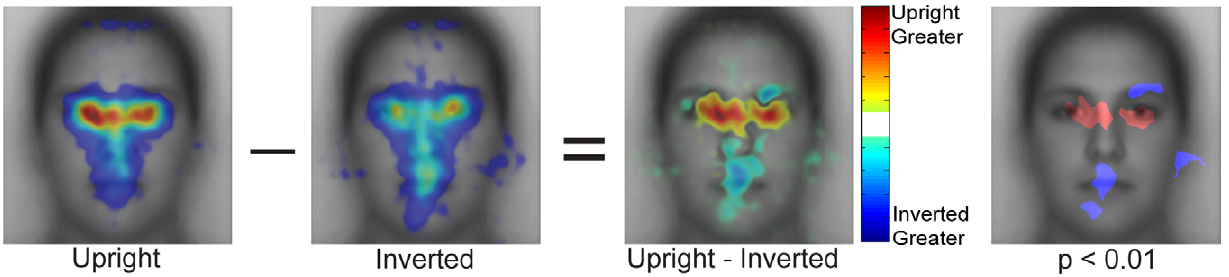
Figure 11. Direct comparison of spatial distributions of fixations for upright and inverted faces. The first two panels show the spatial density of fixations averaged across the peripheral start positions for upright and inverted faces, respectively. Note that there is greater variability in the location of fixations across the internal features for inverted than upright faces, but that the same general pattern holds. The third panel shows the subtraction of the first two panels and the fourth panel shows statistically significant differences. Overall, there are relatively more fixations to the eye region for upright compared to inverted faces and relatively fewer fixations to the mouth region. Fixation density in the raw heatmaps is indicated using a colorscale from zero to the maximum density value observed across the heatmaps pooling the peripheral start positions, with zero being transparent. The difference in fixation density in contrast heatmaps is indicated using a colorscale from plus to minus the largest absolute difference observed in the contrast map.